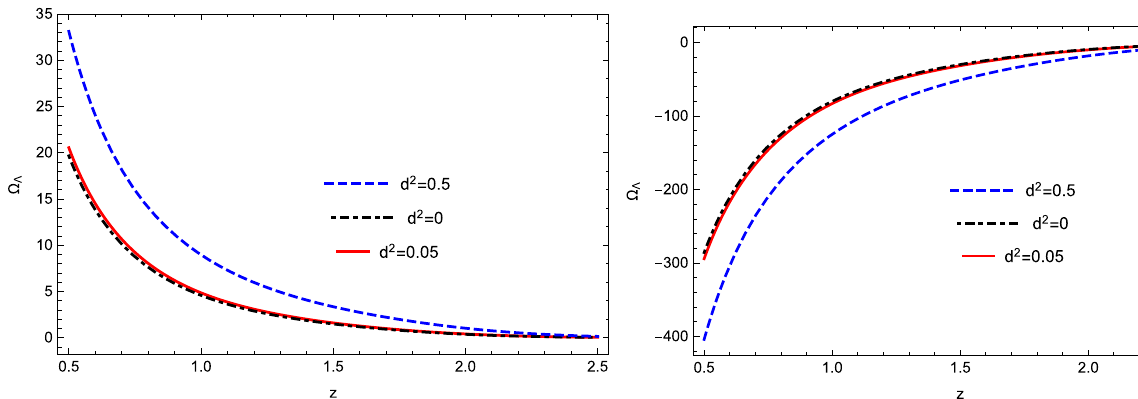
Fig. 31 Plot of (cid:9) (cid:2) verses z for u = 1 and u = 2 . 002 for Bianchi type-VI model